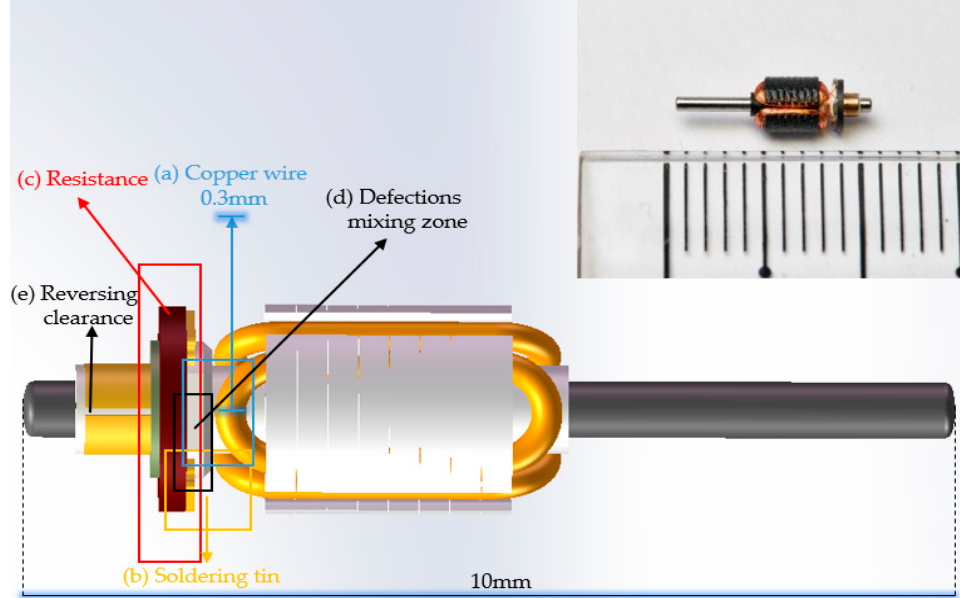
Figure 8. Present the main targets of our detection (( a ), ( b ), ( c )), the region prone to many miscellaneous fatal traps ( d ), ( e ) the commutation gap ( e ).